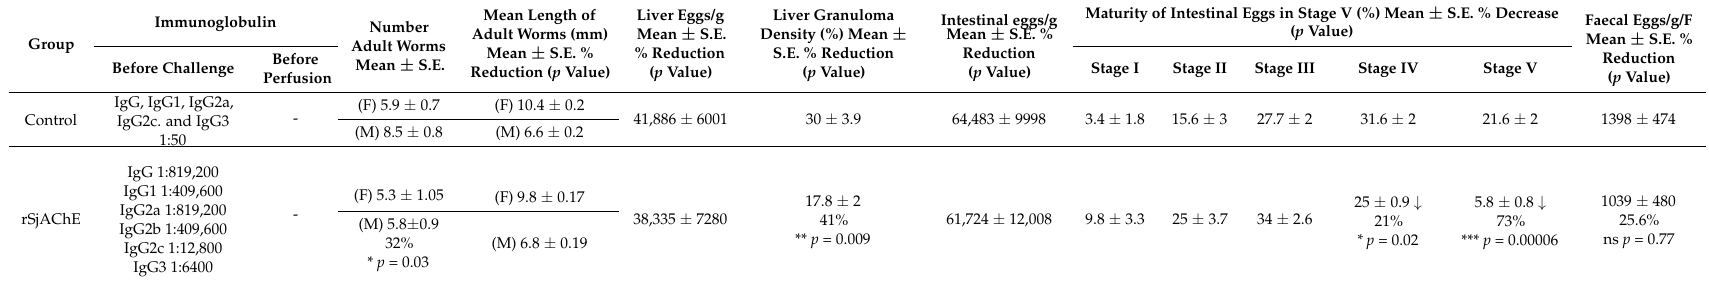
Table 1. Parasitologic and antibody data for vaccinated and control mice challenged with 34 ± 1 Schistosoma japonicum cercariae.